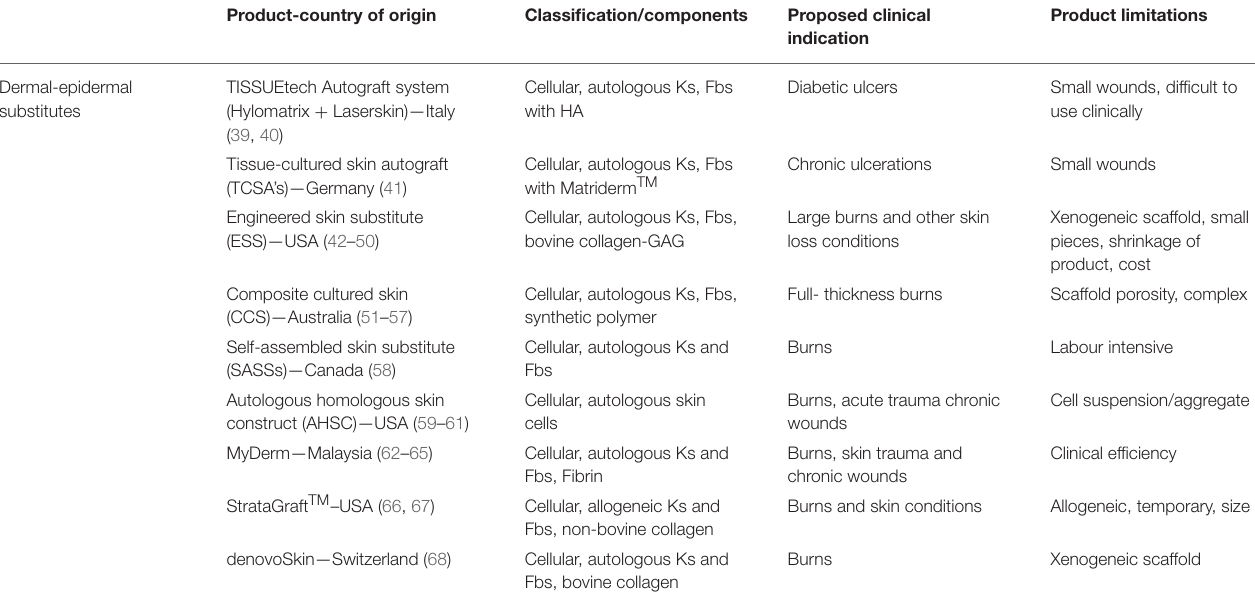
TABLE 1 | Examples of clinically-available or investigative skin substitutes [adapted from Vig et al. (7), Boyce et al. (31)]. Product-country of